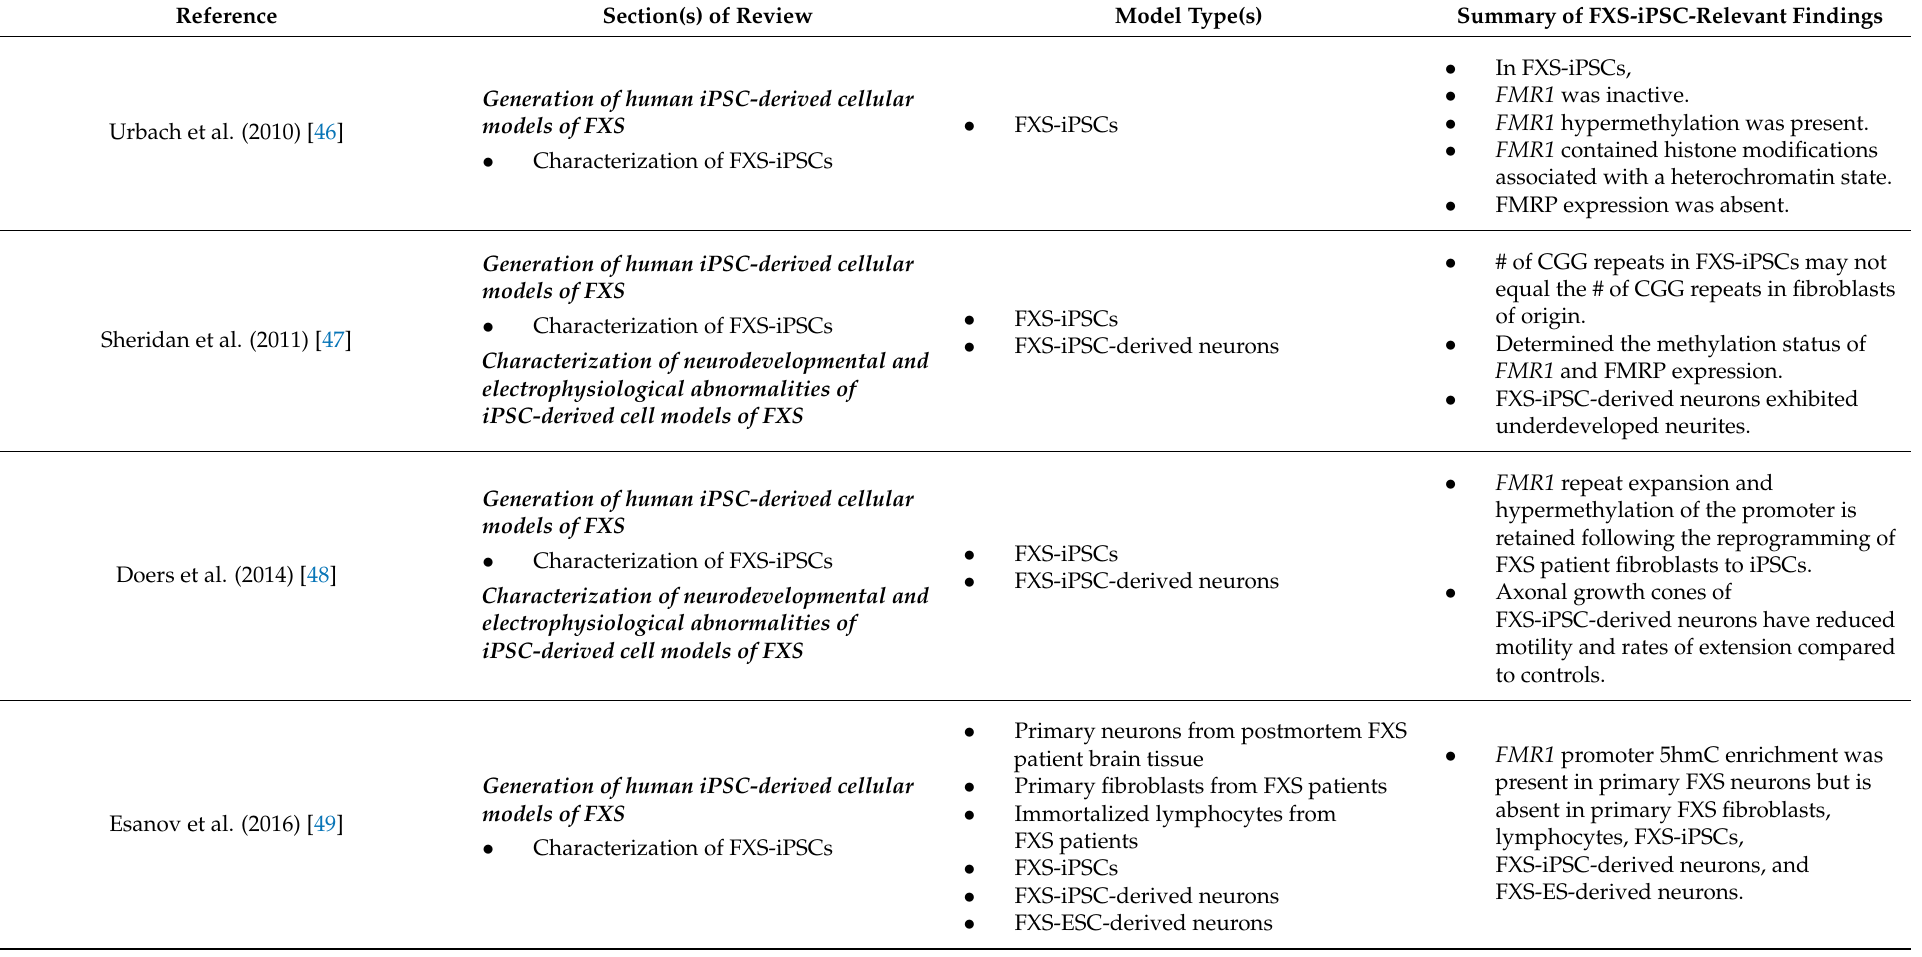
Table 1. Summary of relevant findings from primary literature reviewed in text organized by